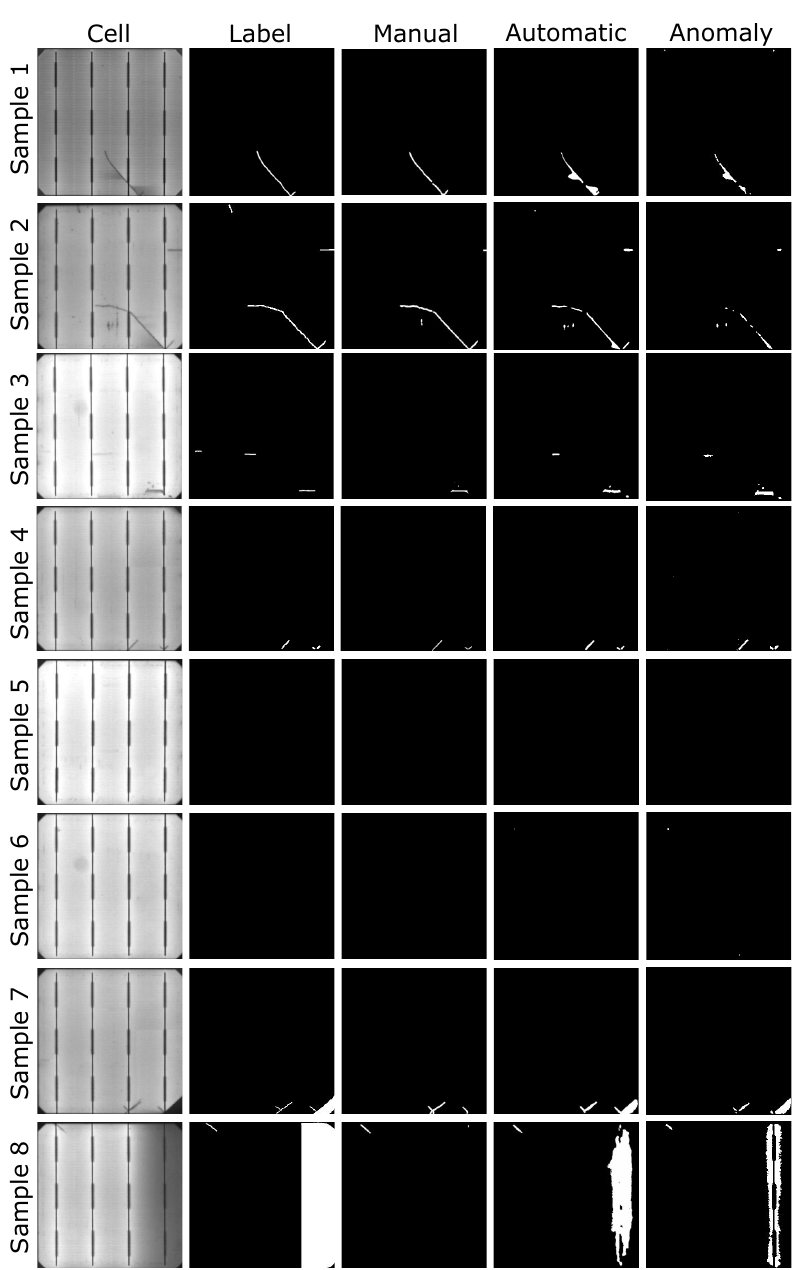
Figure 10. Results from supervised training models and from the anomaly model used for annotation for comparison. Samples 1, 2, 3, and 4 are defective samples with defects contemplated at training and metrics evaluation, and samples 5 and 6 are defect-free samples. Samples 7 and 8 contain defects that were not considered during training and testing but illustrate the effect of the automatic labels in the segmentation results. Label refers to the annotation made by experts, manual refers to the segmentation results obtained from the supervised segmentation model trained with manually labeled samples, and automatic refers to the segmentation results obtained from the supervised segmentation model trained with automatically labeled samples as ground